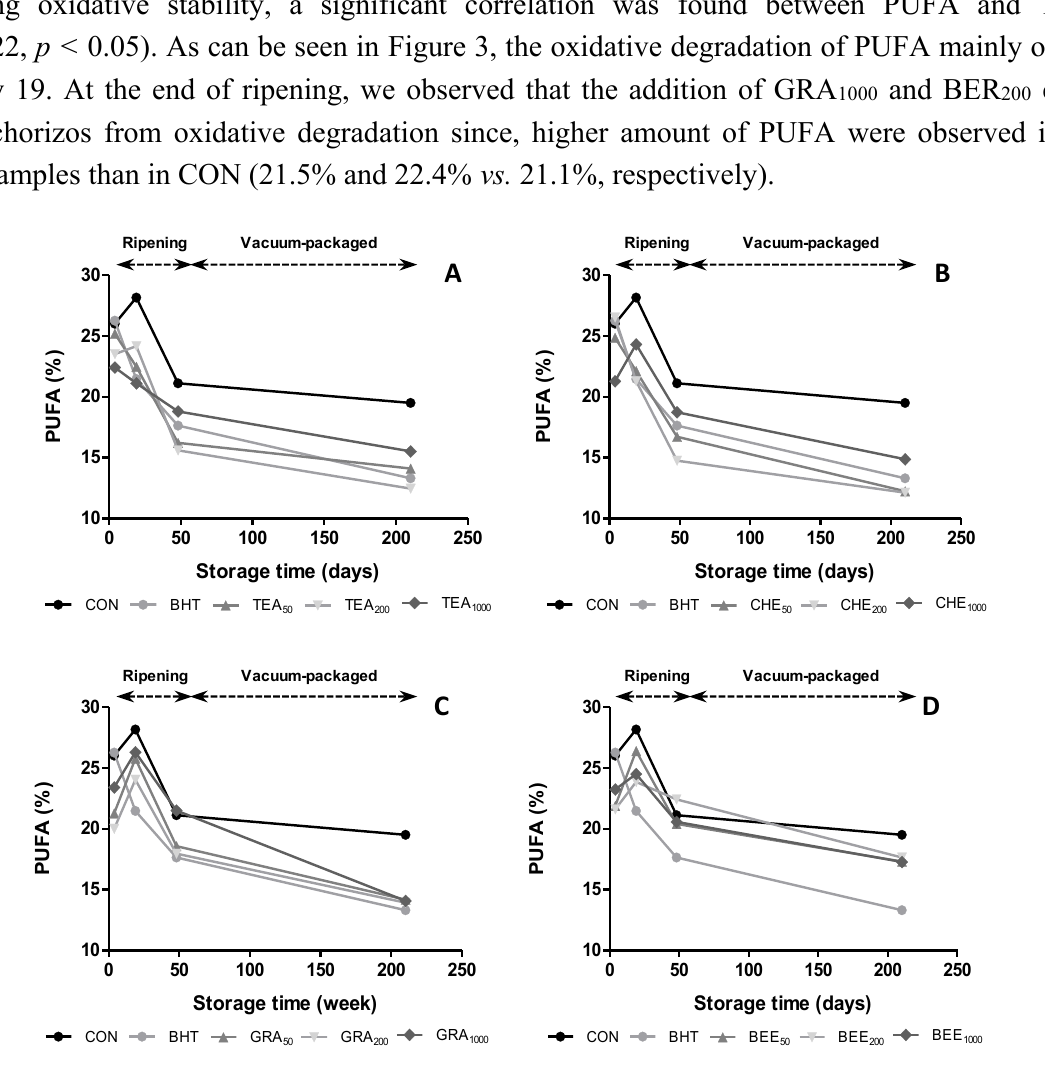
Figure 3. Evolution of PUFA content in dry-cures sausages treated with BHT and natural antioxidants during ripening and vacuum-packaged